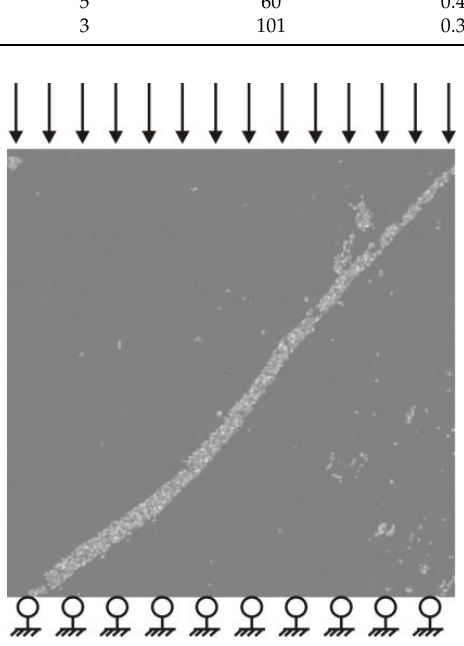
Figure 2. Loading diagram of coal and rock.